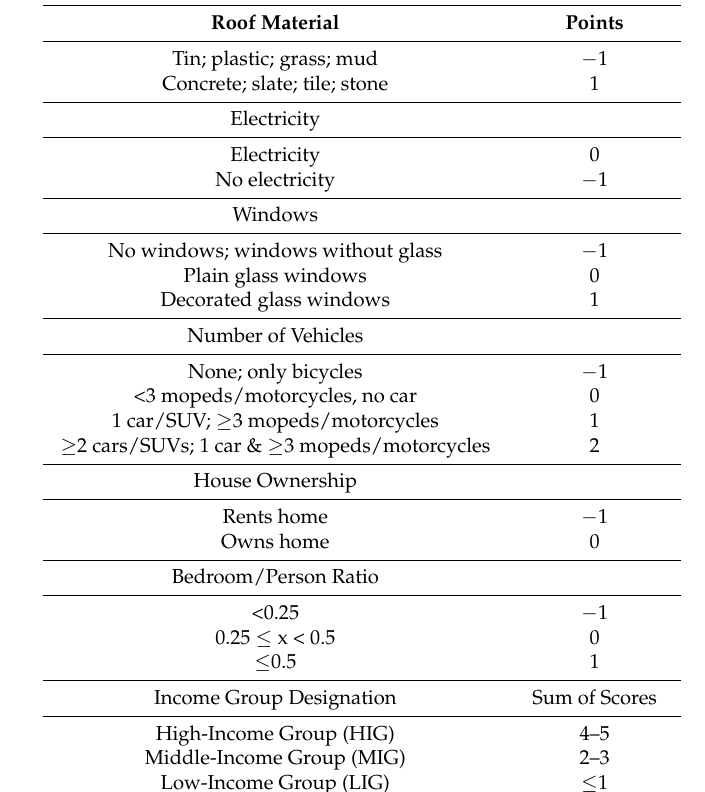
Table 2. Income-group determination criteria.